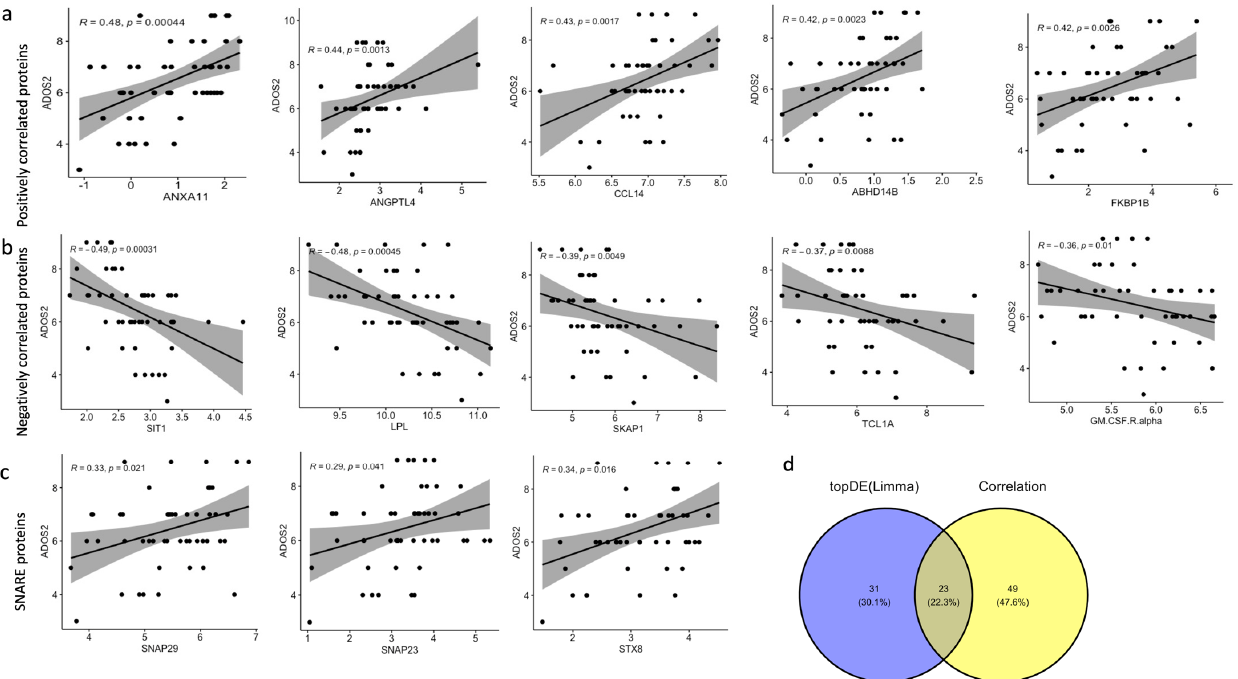
Figure 5. Correlation analysis between the protein NPX values and ADOS-2 score. ( a ) The top five positively correlated proteins with the ADOS-2 score. ( b ) The top five negatively correlated proteins with the ADOS-2 score. ( c ) The correlation between SNARE vesicular transport proteins and the ADOS-2 score. The correlation coefficients with the associated p-values are shown in each figure. ( d ) A Venn diagram of the overlapping proteins between the TopDE and the significantly correlated proteins ( p -value < 0.05) with a correlation coe ffi cient > 0.3 and < − 0.3.